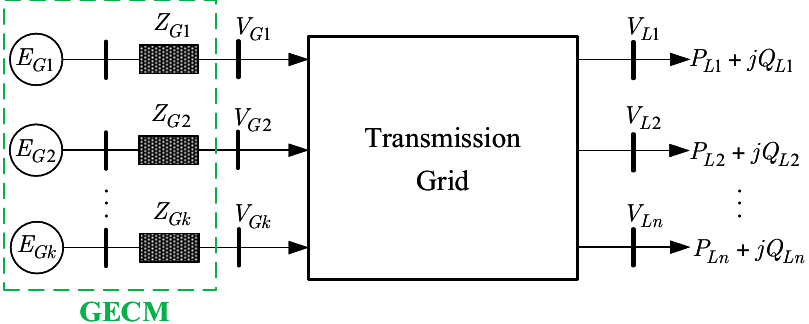
Figure 4. Multi-node network transmission grid model where generators are modeled by the GECMs.